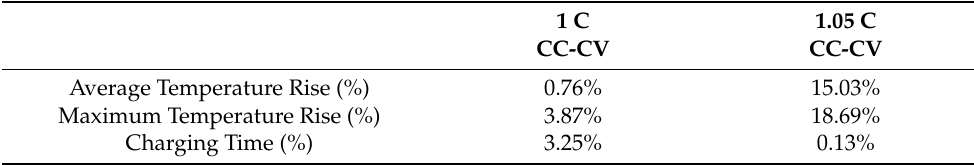
Table 7. Improvement of the proposed method over different CC-CV methods.